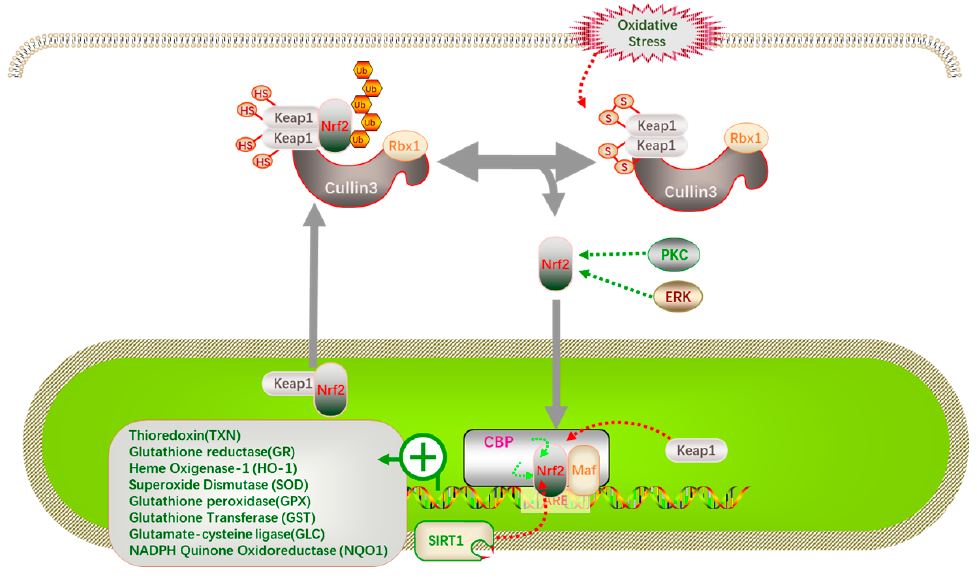
Figure 5. Antioxidant pathways [75–77]